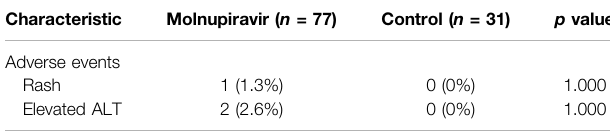
TABLE 3 | Summary of adverse events in the two groups. Characteristic